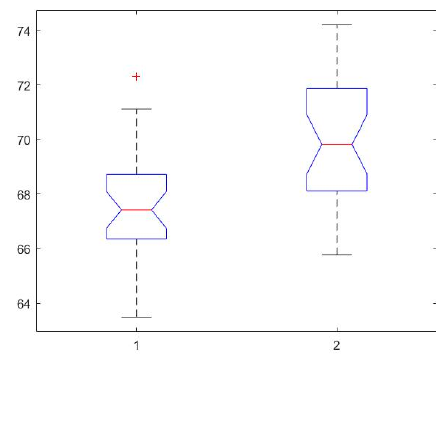
ANOVA test—test data results